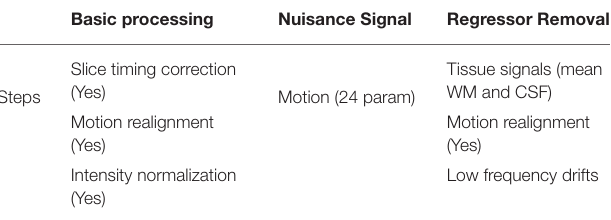
TABLE 3 | Overview of the basic parameters and steps of used by